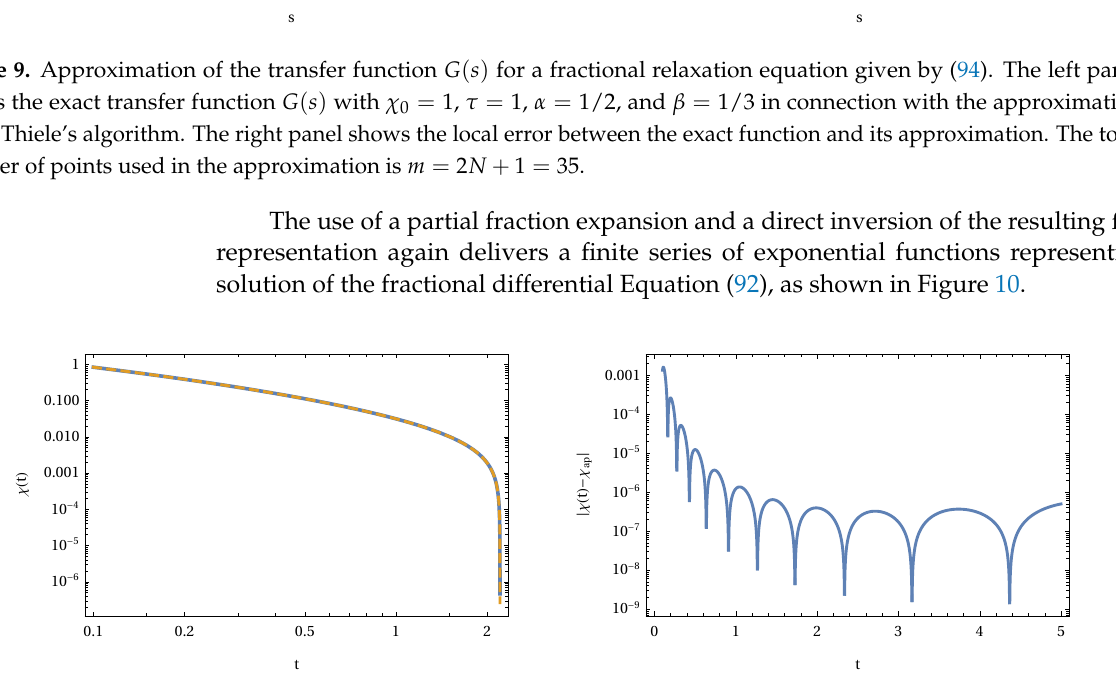
Figure 10. Solution of the fractional relaxation Equation (92) generated by the inverse Laplace transform of ˜ G ( s ) . The left panel also includes the exact solution of the fractional relaxation equation given by χ ( t ) = χ 0 t β − 1 E α , β ( − ( t / τ ) α ) , where E α , β ( z ) is the two parameter Mittag-Leffler function. The right panel shows the local error between the exact solution and the approximation. The number of approximation points used in the calculation was m = 2 N + 1 = 35. The parameters to generate the plot are χ 0 = 1, τ = 1, α = 1/2, and β =